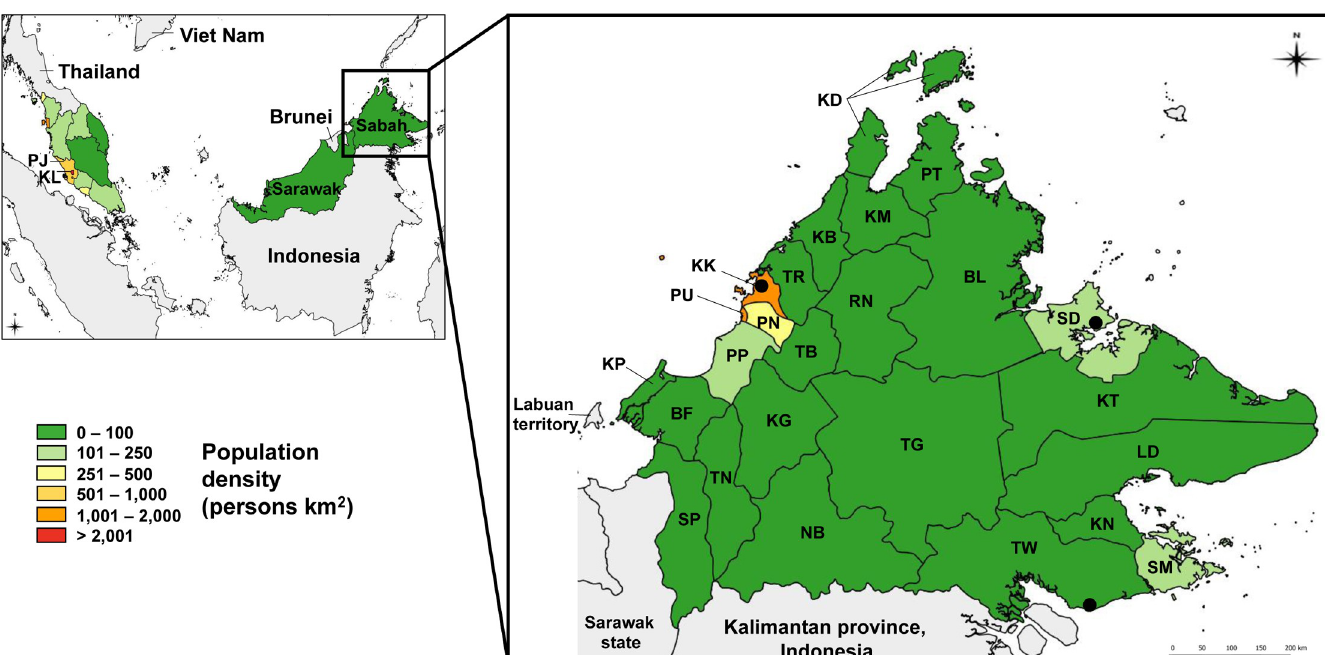
Fig 1. Map of Malaysia and Sabah state. Peninsula Malaysia and Malaysian Borneo are shown, along with the 13 Malaysian states and 3 territories: Kuala Lumpur (KL), Putrajaya (PJ) and Labuan. States are coloured according to their population density, expressed as number of people per square km. The island of Borneo includes the Malaysian states Sabah and Sarawak, and is also shared by the country of Brunei and the Indonesian province of Kalimantan. Inset : Sabah state, showing its 25 districts: Beaufort (BF), Beluran (BL), Keningau (KG), Kinabatangan (KT), Kota Belud (KB), Kota Kinabalu (KK), Kota Marudu (KM), Kuala Penyu (KP), Kudat (KD), Kunak (KN), Lahad Datu (LD), Nabawan (NB), Papar (PP), Penampang (PN), Pitas (PT), Putatan (PU), Ranau (RN), Sandakan (SD), Semporna (SM), Sipitang (SP), Tambunan (TB), Tawau (TW), Tenom (TN), Tongod (TG), Tuaran (TR). The three largest cities in the state are indicated by black points: the capital city Kota Kinabalu, Sandakan and